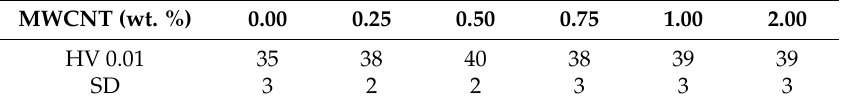
Table 2. Microhardness values of specimens compacted at ~300 MPa and sintered. MWCNT (wt.